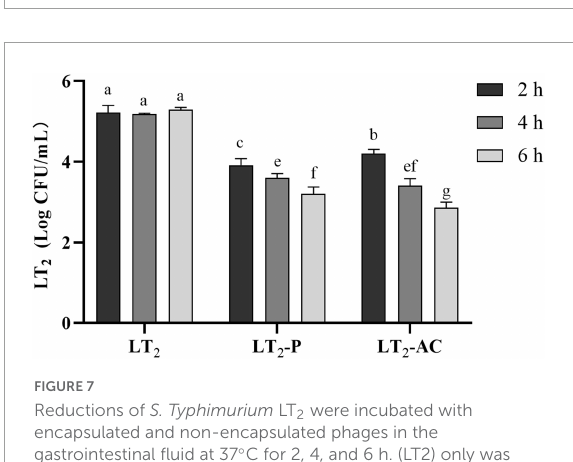
FIGURE7 Reductions of S. Typhimurium LT 2 were incubated with encapsulated and non-encapsulated phages in the gastrointestinal fluid at 37 ◦ C for 2, 4, and 6 h. (LT2) only was added S. Typhimurium LT 2 as control, (LT 2 -P) added free phage SL01, (LT 2 -AC) added microencapsulated phage. Different letters a–g indicate significant differences ( p <